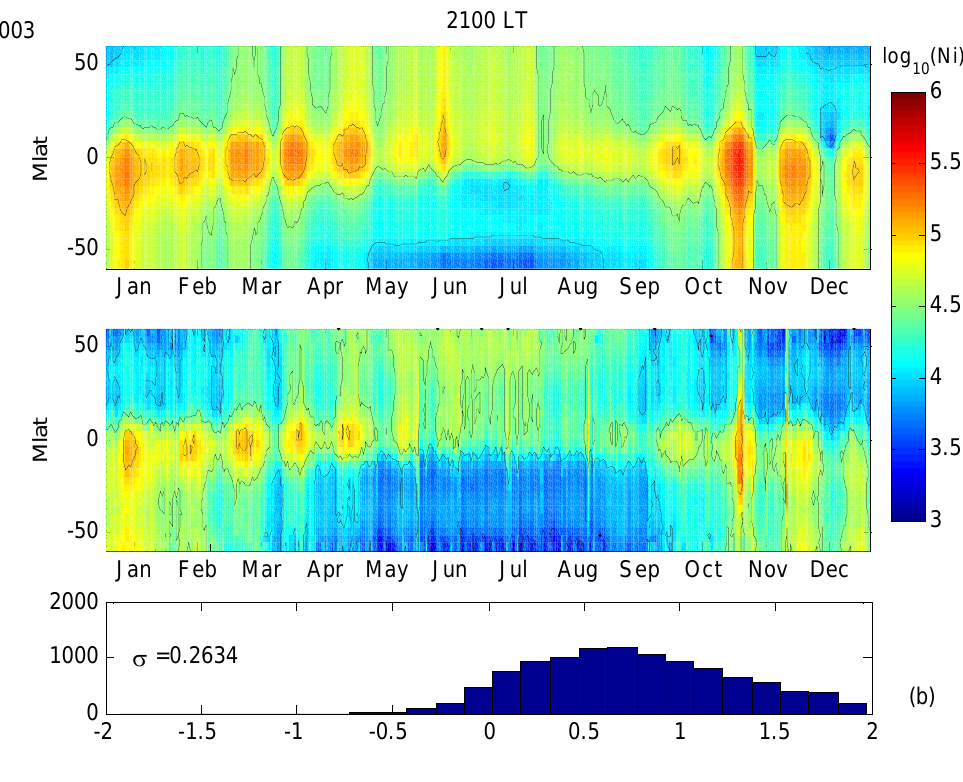
Figure 11. Comparison between the predicted and observed Ni for the year 2004 at each figure represents the histogram of the percentage error %100)/( ×− NiNiNi mod